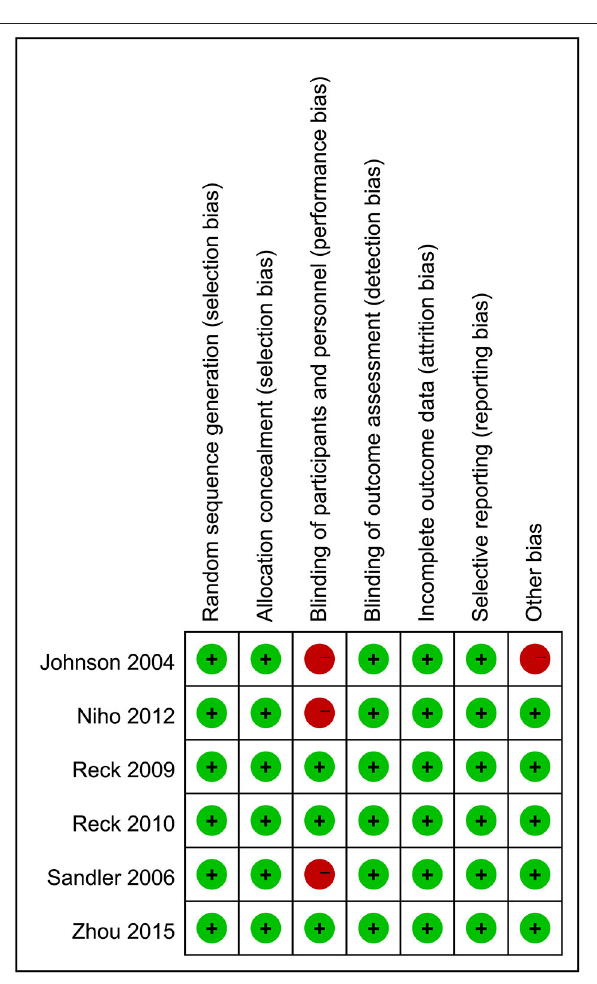
overall OS was significantly longer only in patients treated with bevacizumab (15 mg/kg) plus CP than with CP, but not in patients treated with bevacizumab (7.5 mg/kg) ( Figure 3B